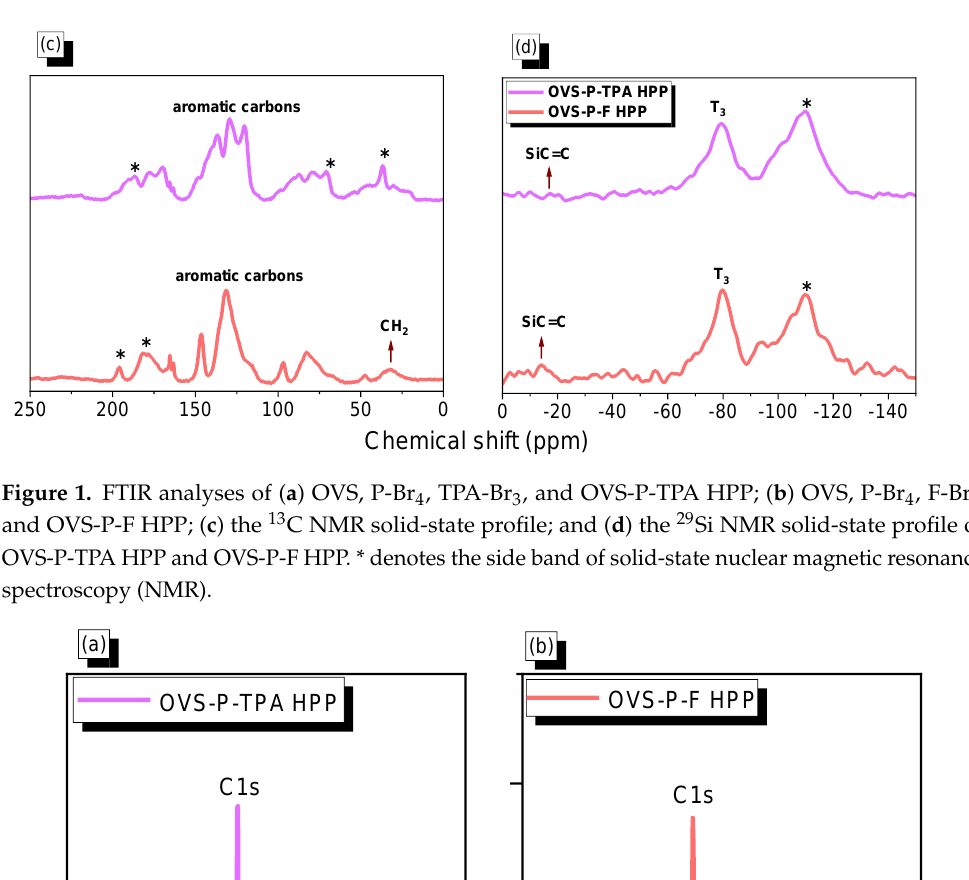
Table 1 . TGA, BET, and capacitance data for the OVS-HPPs materials. Sample